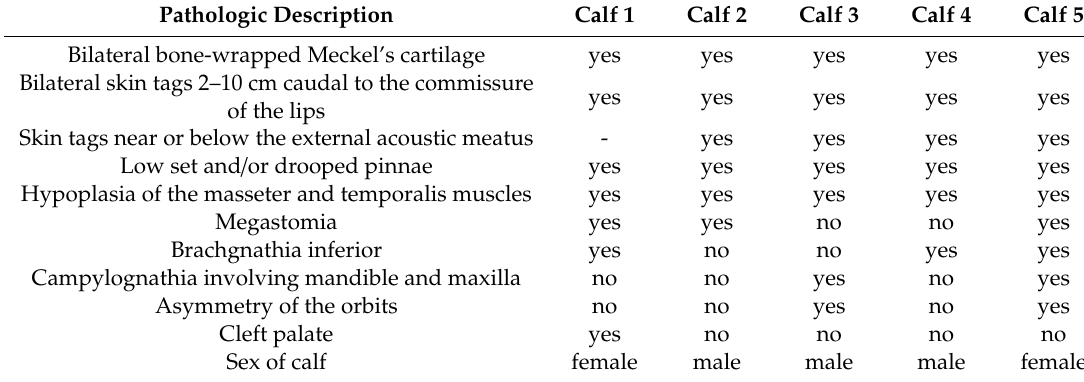
Table 1. Pathologic characteristics of mandibulofacial dysostosis calves. Given is a list of the hallmark and variable characteristics observed in MD calves and indicators of which animals displayed each.